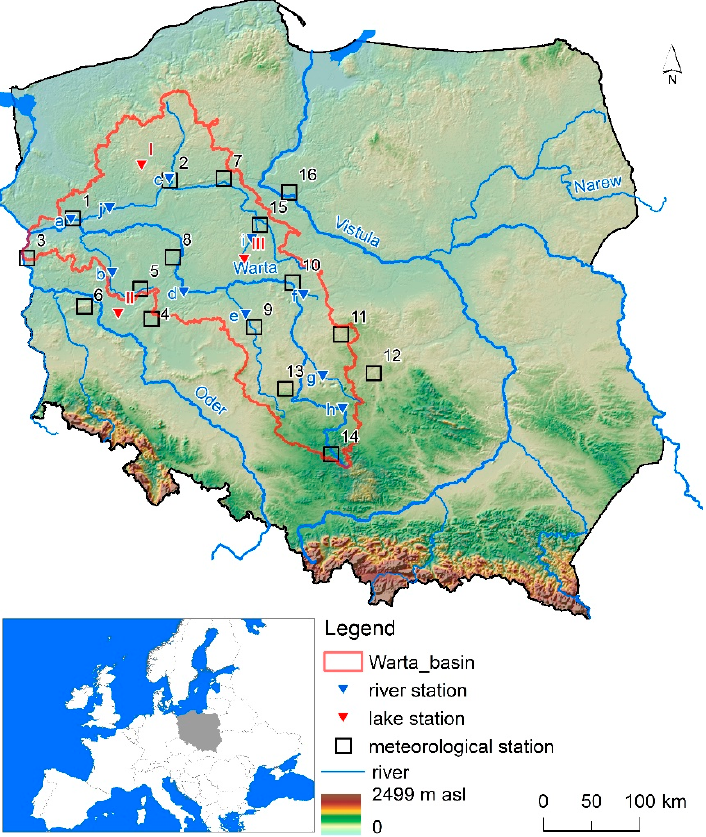
Figure 1. Analysed hydrological and meteorological stations. Numbering of stations in accordance with Table 1 (letters denote hydrological stations on rivers, roman numerals denote hydrological stations on lakes, digits denote meteorological stations). Table 1. Analysed hydrological stations on rivers and lakes, and meteorological stations.